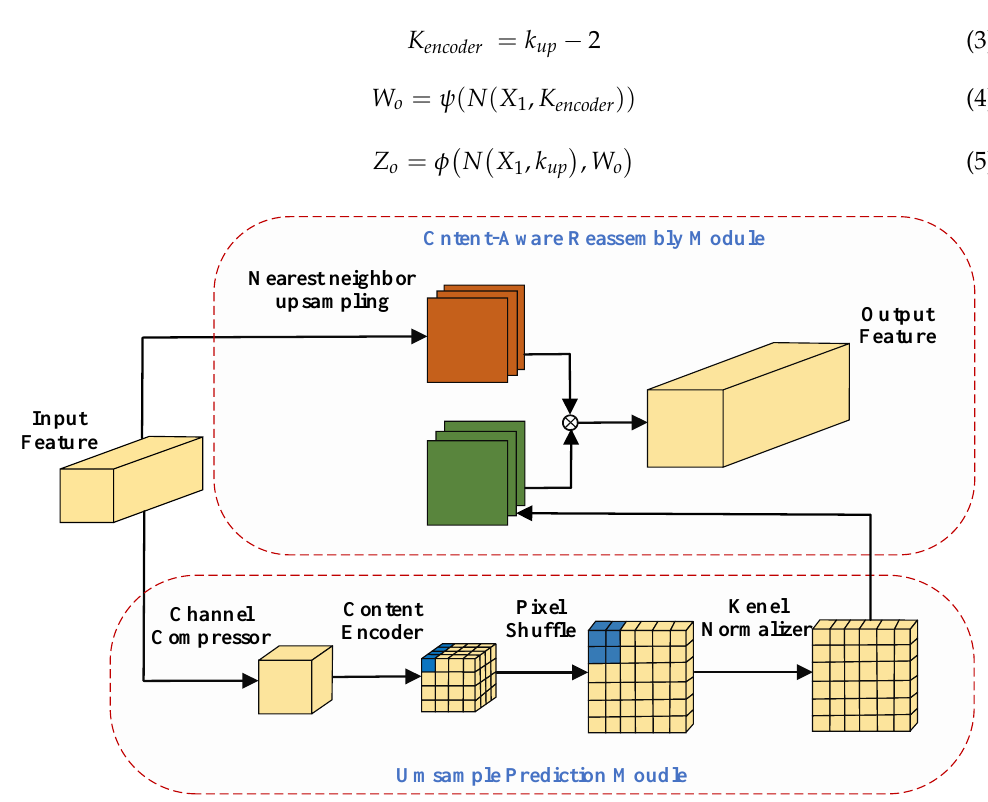
Figure 5. Flow of CARAFE.